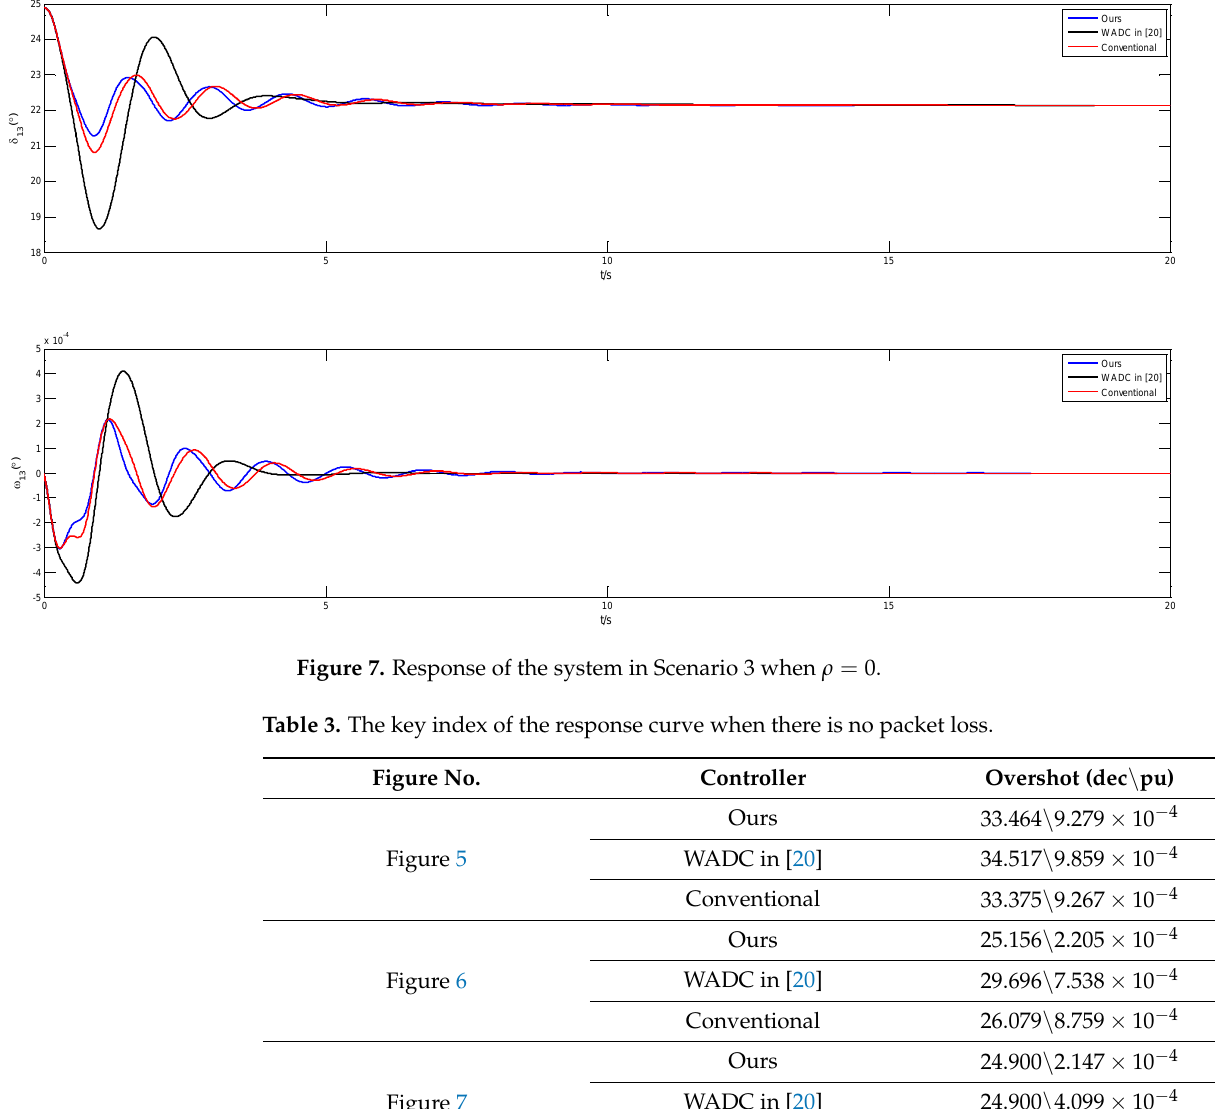
Figure 6. Response of the system in Scenario 2 when 𝜌 = 0 .